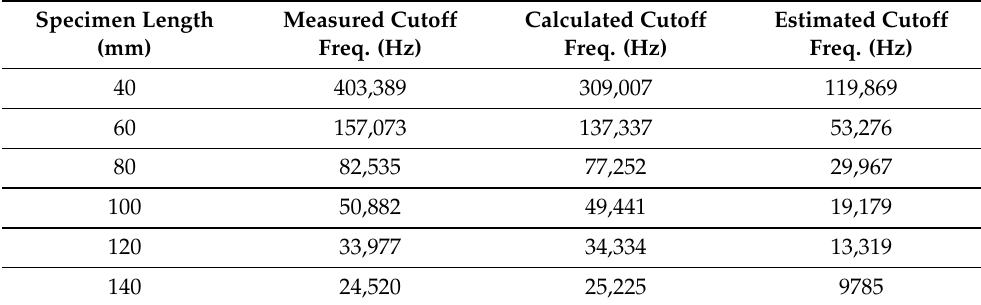
Table 2. Measured, calculated and estimated low-pass cutoff frequencies for different 3D-printed PE sensor